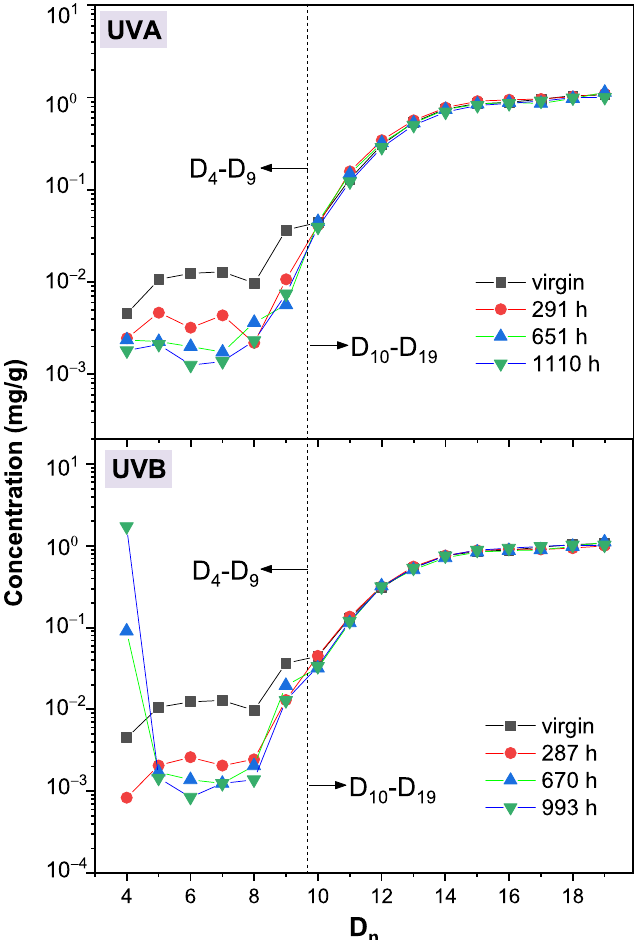
Figure 5. The calculated concentration of cyclic LMW siloxanes in virgin and exposed samples: UVA exposed ( upper ); UVB exposed ( below